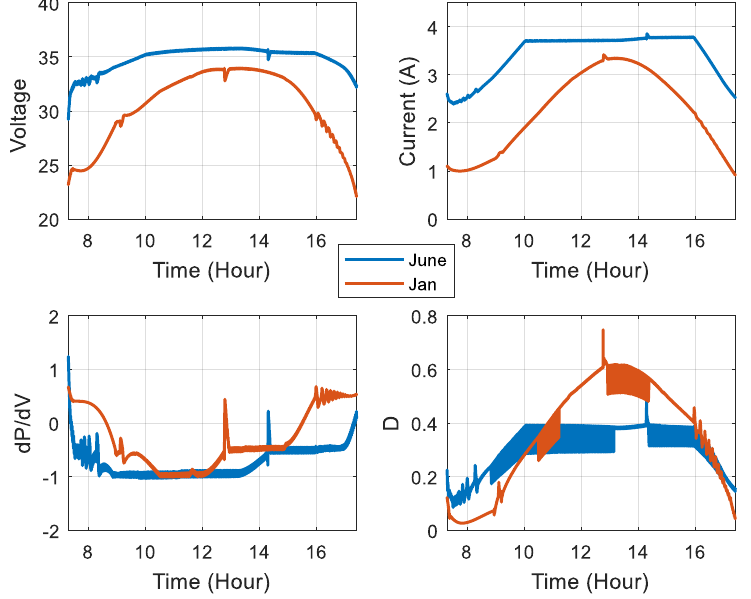
Energies 2019 , 12 , x FOR PEER REVIEW Figure 17. Output power for the months of January and June cases with a load of 15 Ω . Figure 17. Output power for the months of January and June cases with a load of 15 Ω.